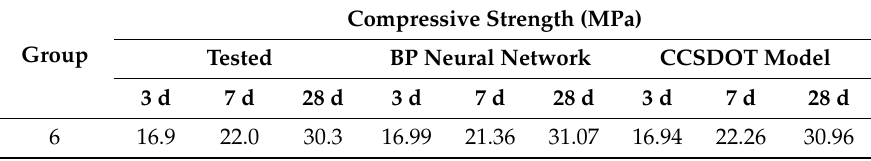
Table 4. Compressive strength of green concrete containing fly ash and limestone flour. BP: back propagation.